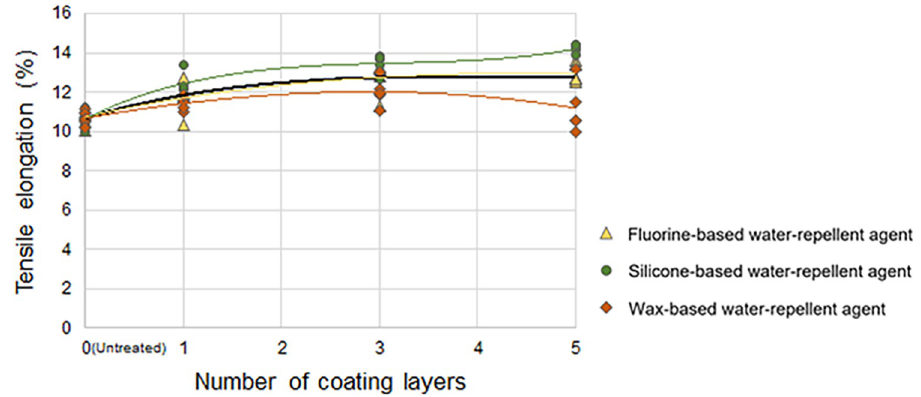
Fig 7. Tensile elongation of the cotton woven fabric according to the number of coating layers of the water- repellent agent. The black line represents the trendline (third-order polynomial).